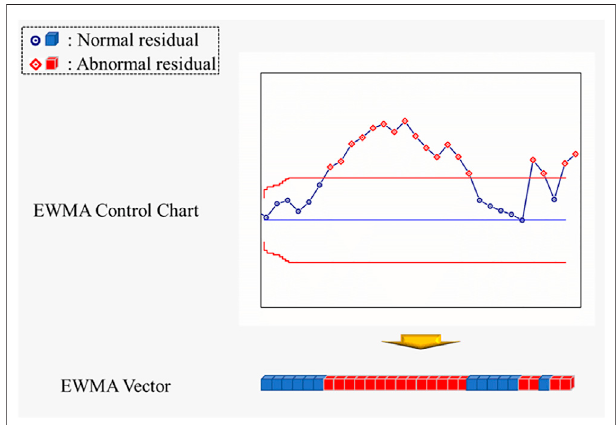
FIGURE 3 | Vectorization of residuals using EWMA control